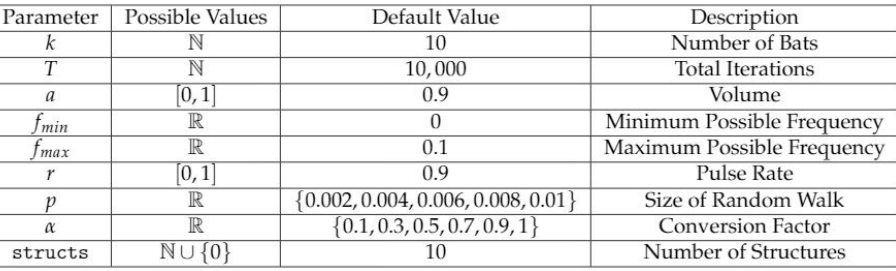
Figure 4. Hyperparameters in ChromeBat. Note that in the original work, certain variables such as r and a were proposed to change as the algorithm progressed. In ChromeBat, they are constant throughout. For more information about the default value selection, see Section